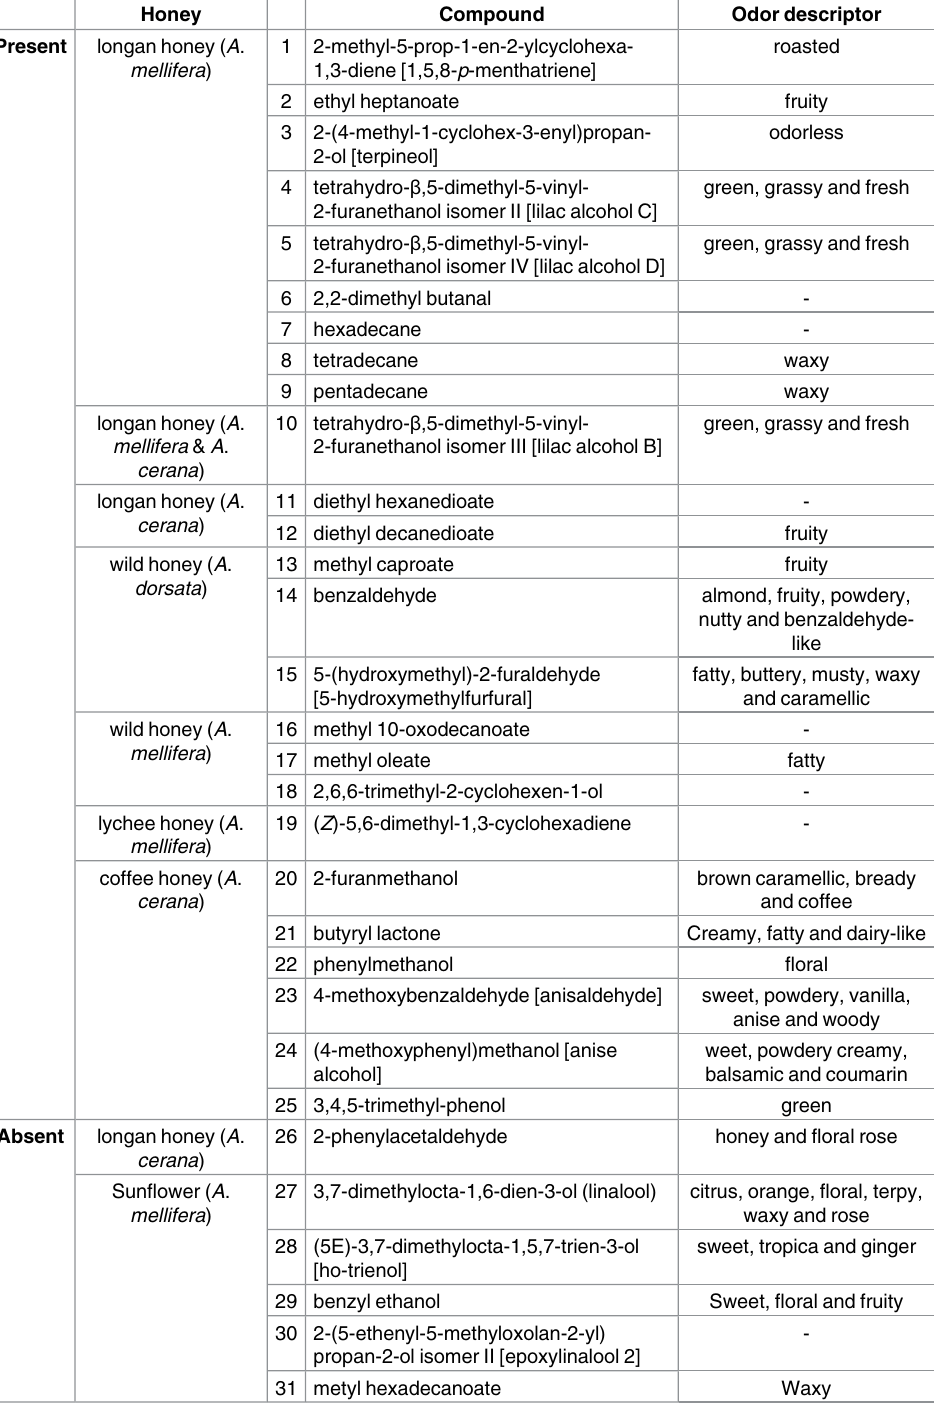
Table 2. List of VOCs that could serveas possible floral markersand their odor